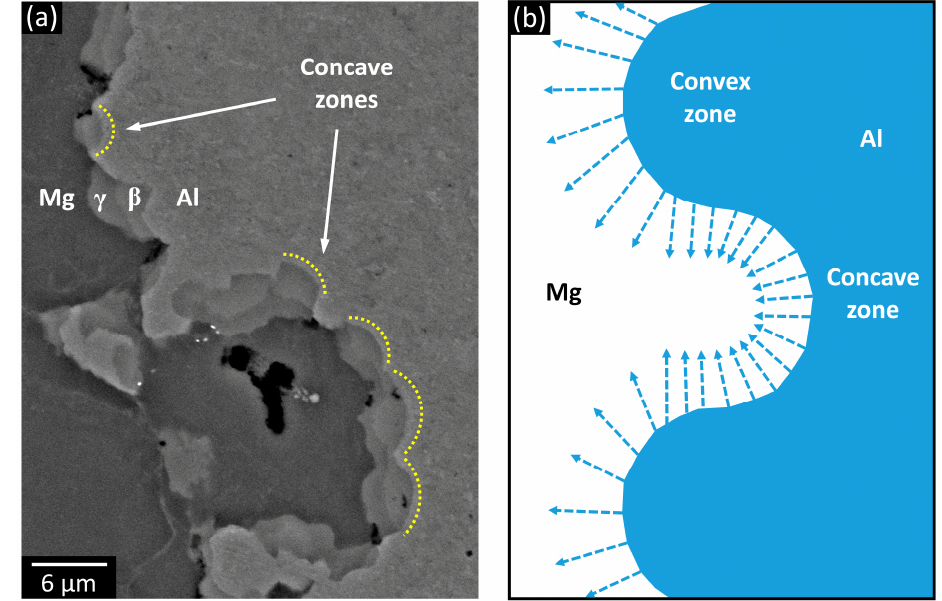
Figure 7. ( a ) The SEM image of the Al-Mg interface in the bilayer composite hot-pressed at 623 K showing the preferential formation of the intermetallic phases at the concave zones of the aluminum surface. ( b ) The schematic representation of the linear paths of the diffusion of aluminum atoms in the Al-Mg bilayer.